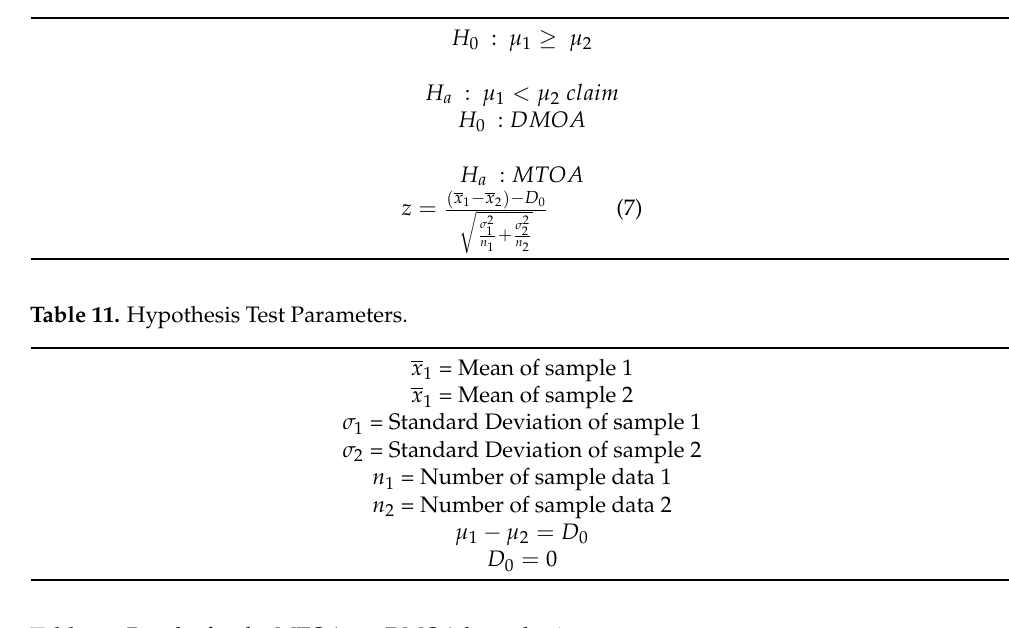
Table 12. Results for the MTOA vs. DMOA hypothesis